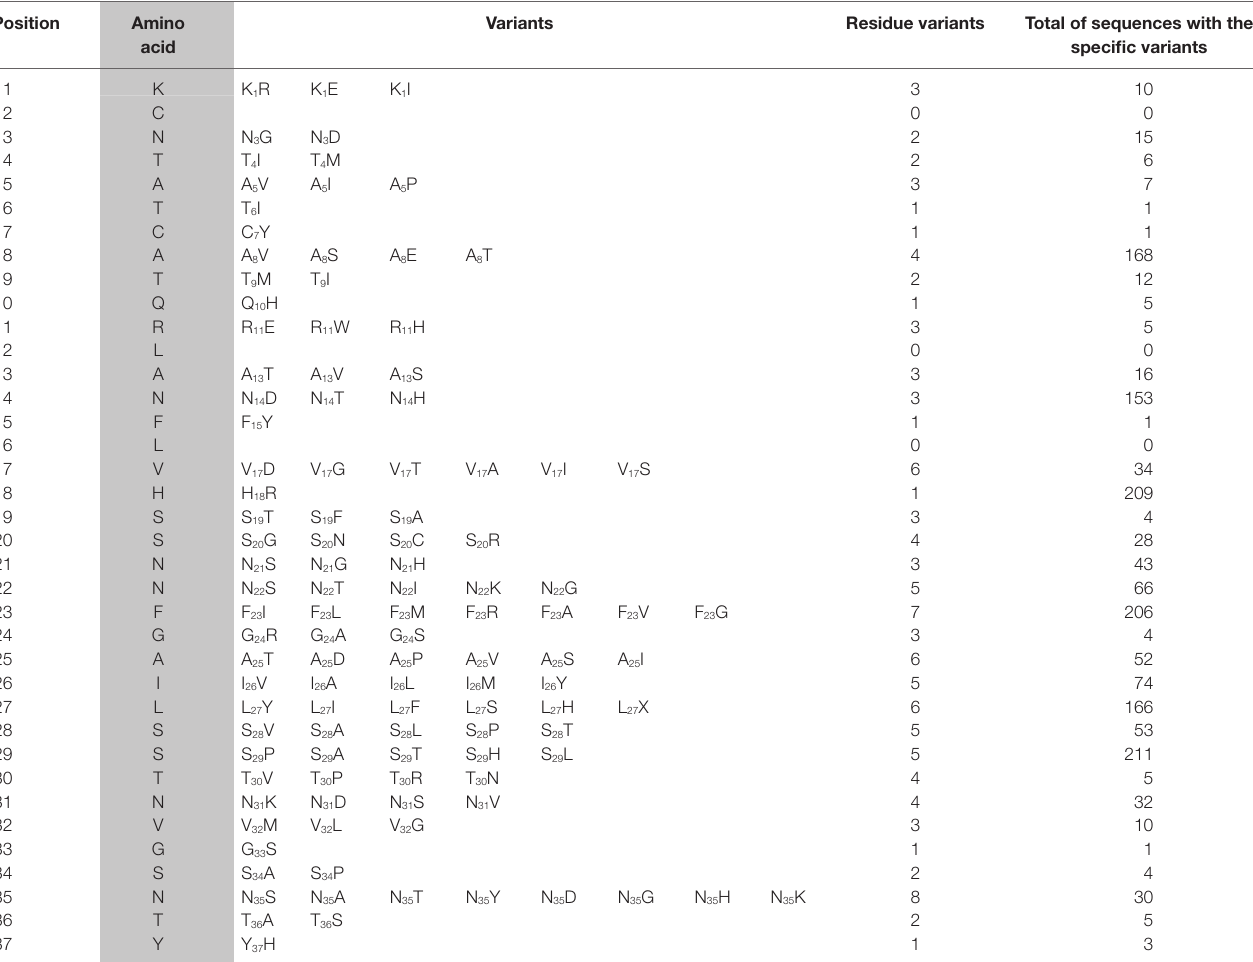
The amino acids of the hIAPP sequence are shown in gray